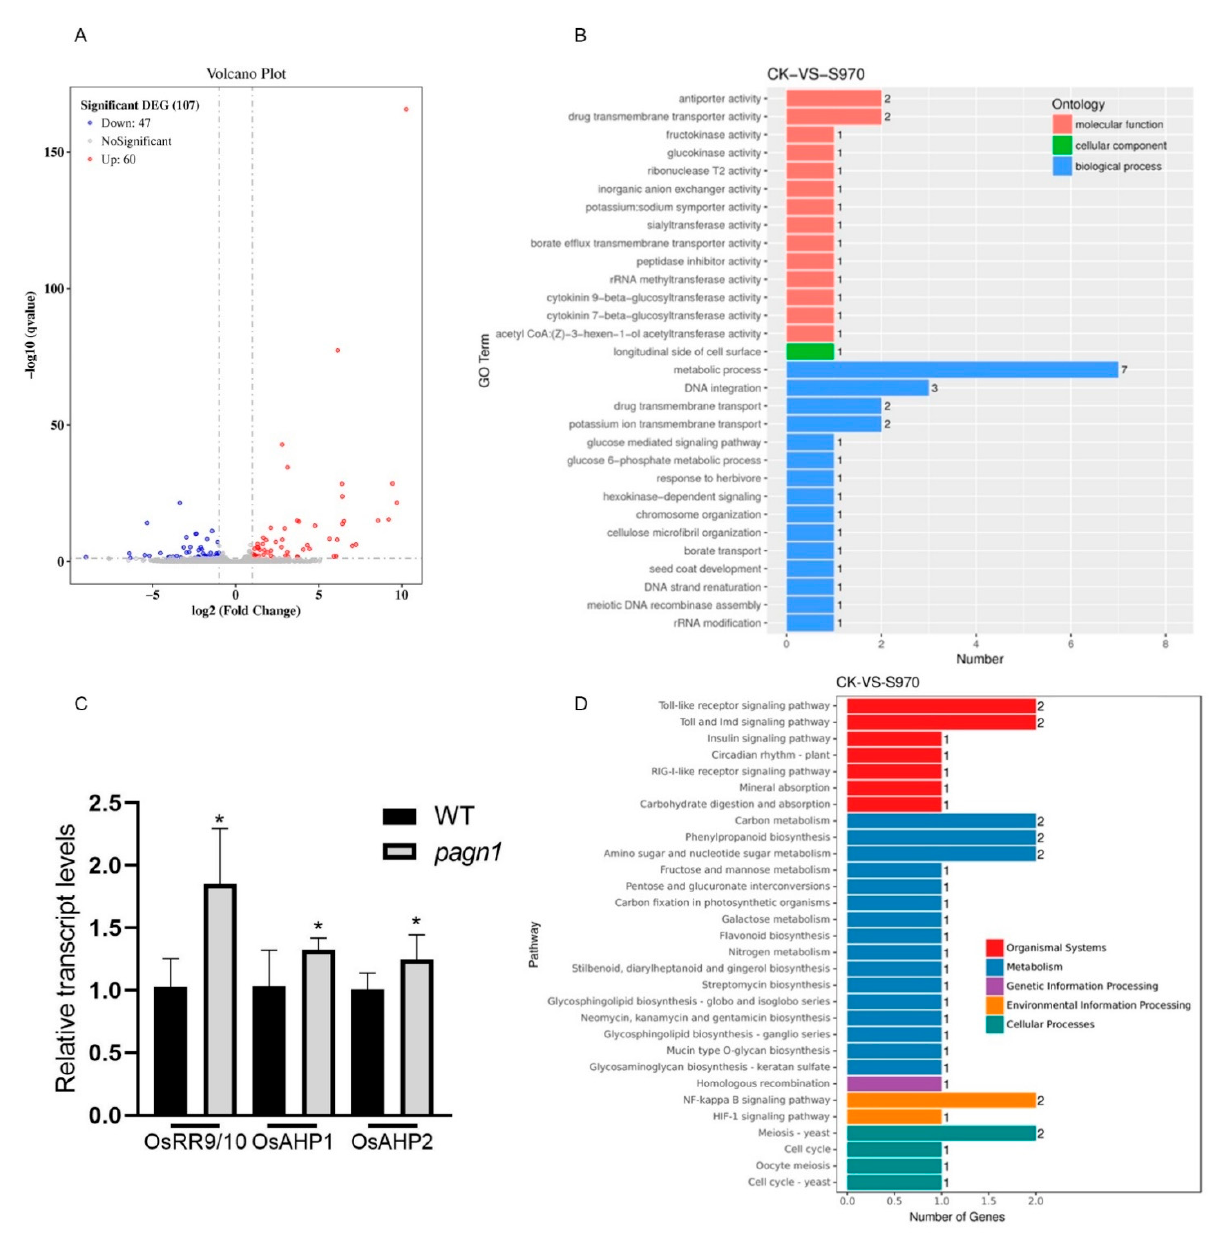
Figure 4. Differentially expressed genes in the young panicles of OsPAGN1 knockout lines. ( A ) Volcano plot of genes regulated in both pagn1 plants. ( B ) GO analysis of DEGs. ( C ) Transcript levels of genes involved in the cytokinin signaling pathway. ( D ) KEGG pathway enrichment analysis of DEGs. The data are the mean ± SEM. * p < 0.05. (Student’s t test).